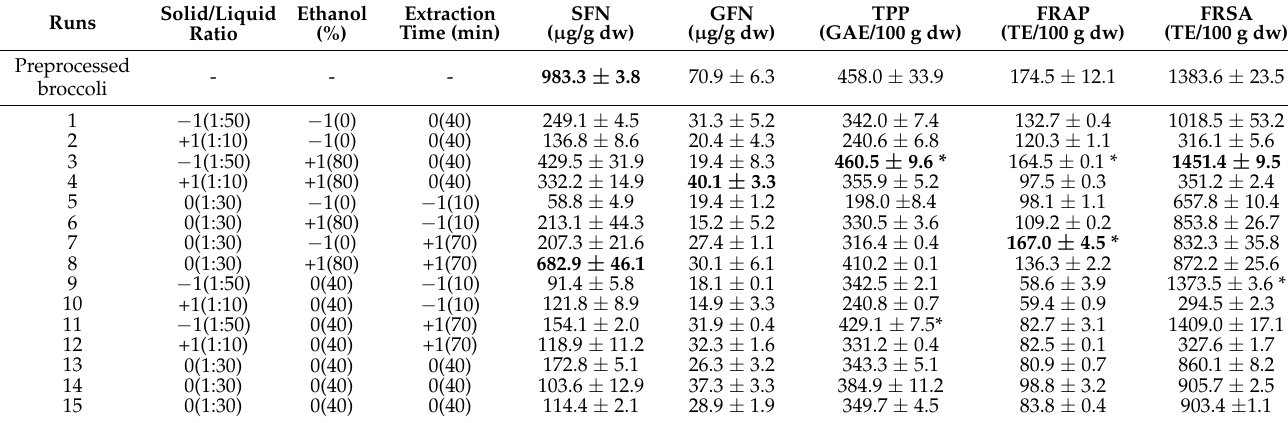
Table 1. Experimental matrix. SFN = sulforaphane; GFN = glucoraphanin; TPP = total polyphenols content; FRAP = ferric-ion-reducing ability; FRSA = free radical scavenging ability; GAE = gallic acid equivalents; TE = Trolox equivalents; dw = dry weight. Maximum values are highlighted in bold. “*” indicates no statistically significant difference in broccoli (Student’s t test at 95% confidence).